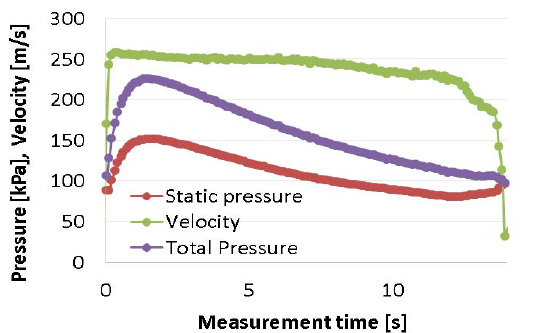
Fig. 11. The typical profile of the stagnation and static pressure and velocity profile around the